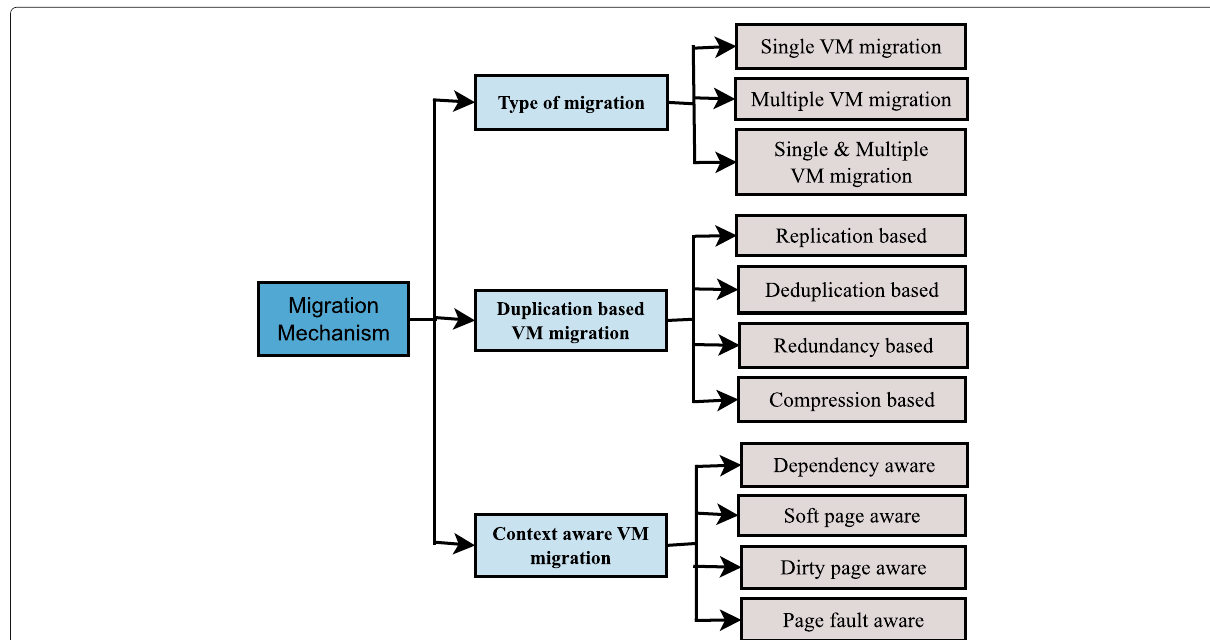
Fig. 6 Classification of migration